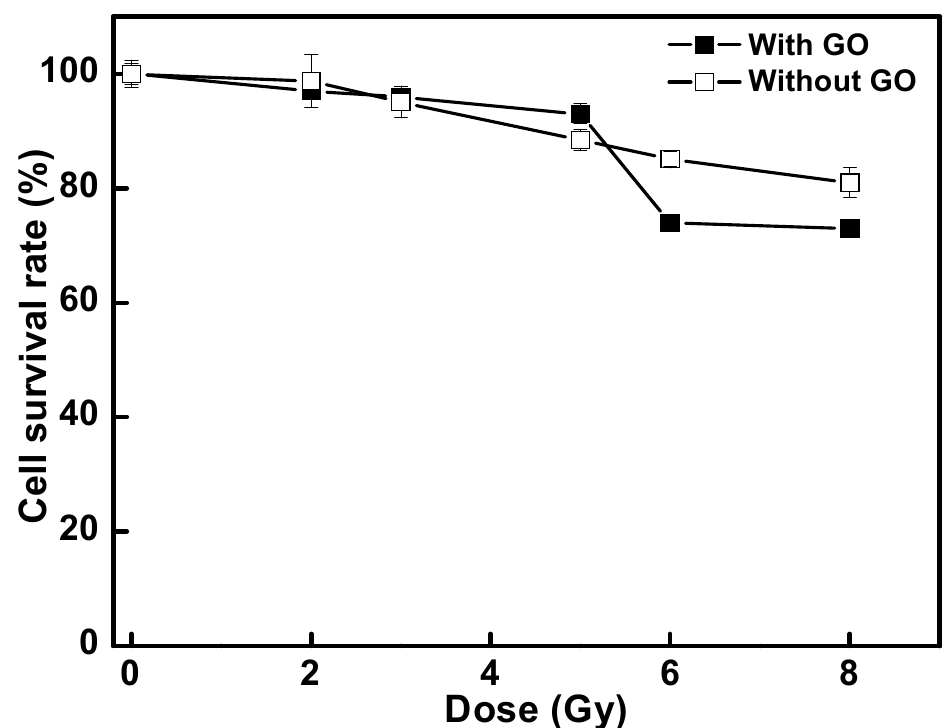
Figure 6. ( a ) FTIR spectrum of pristine and GO-treated NPC-BM1 cells, ( b , f ) microscopy images, and SR-FTIRM mapping of amide I, amide II and phosphate groups for ( c – e ) pristine NPC-BM1 cell and ( g – i ) NPC-BM1 cell treated with GO.